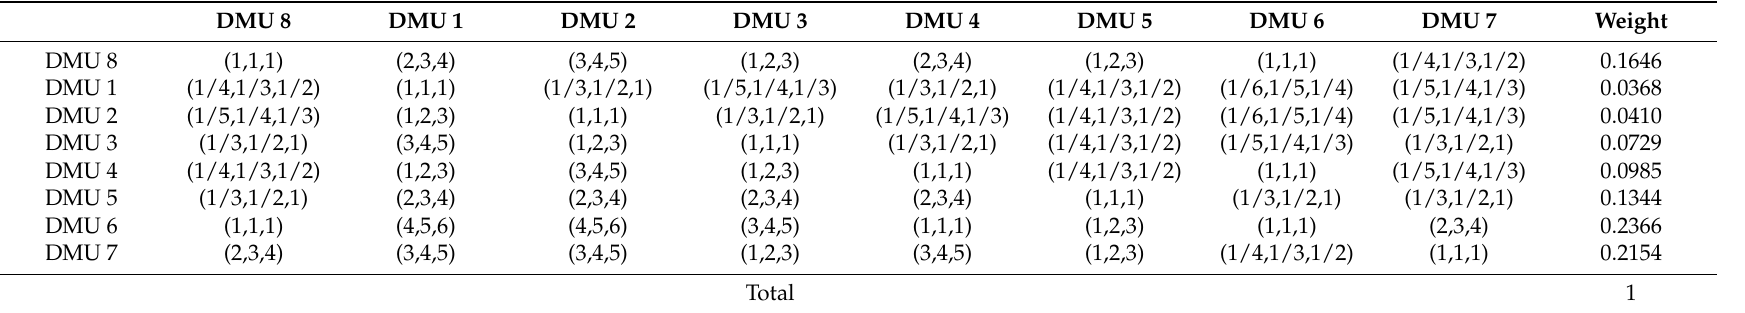
Table A30. Comparison matrix for POD based on alternatives.